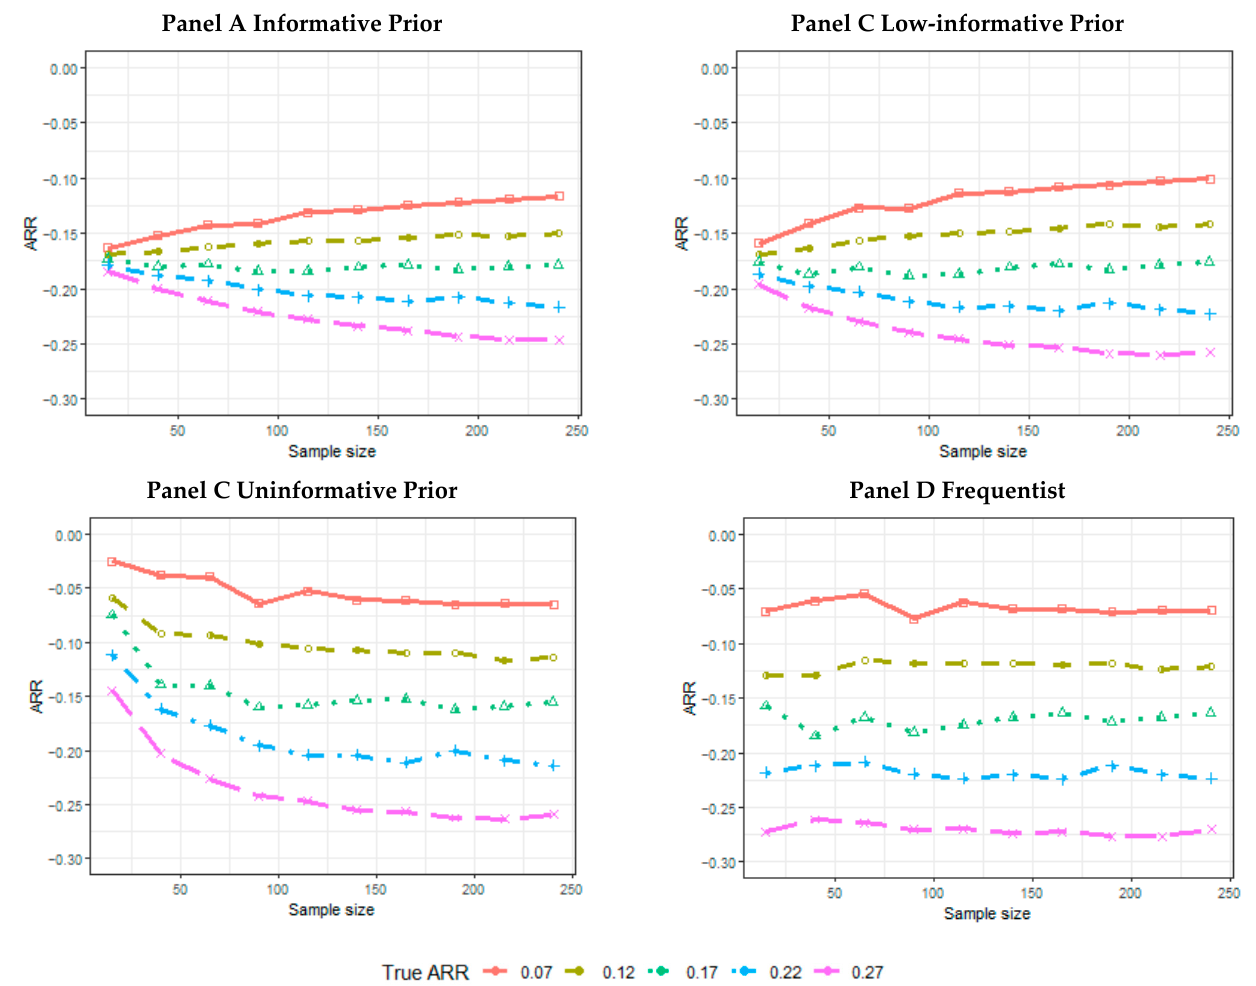
Figure 4. Simulation results for the estimated ARR (posterior median, or point estimate, for frequentist analysis) according to the sample size and true ARR for informative prior (Panel A), low-informative prior (Panel B), uninformative prior (Panel C), and frequentist analyses (Panel